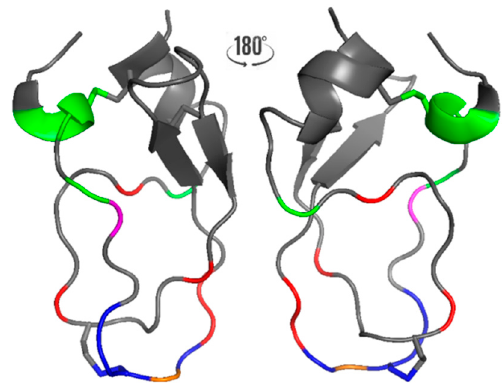
Figure 2. X-ray structure of the variant MQ1 NG15/16KA (PDB 5m4v). Colors identify pharmacophores: green for the dendrotoxin, blue for trypsin inhibitor and red for MQ1. Overlapping pharmacophores between dendrotoxin and MQ1 are indicated in magenta, and those between the trypsin inhibitor and MQ1 are indicated in orange.